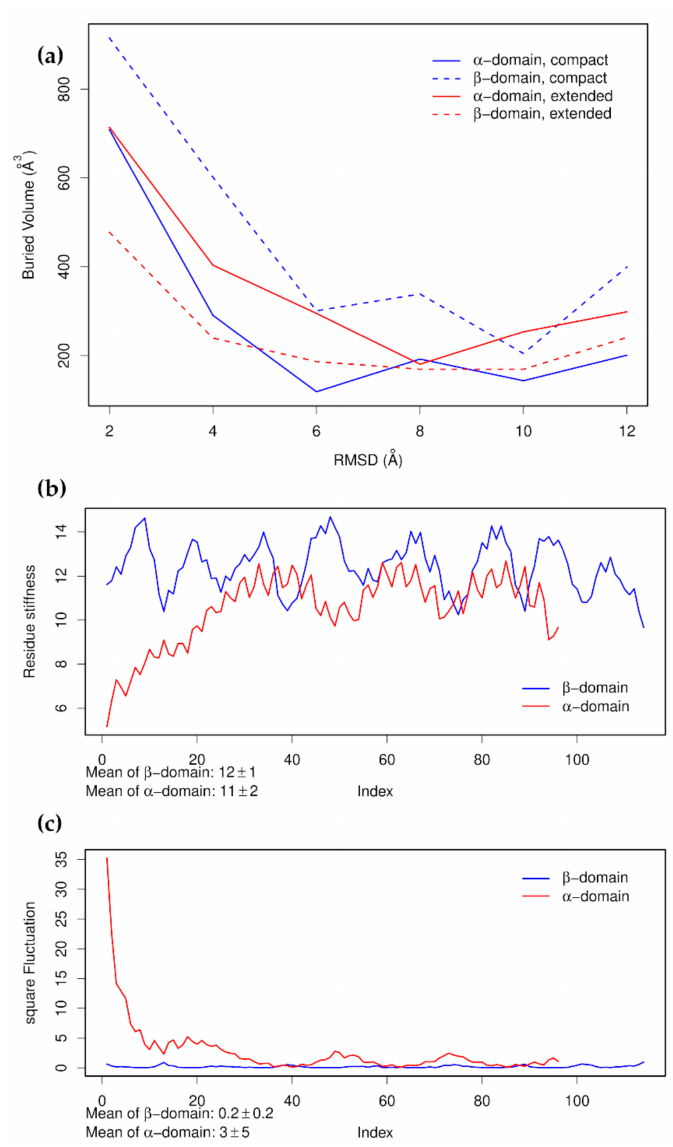
Figure 6. Plots showing ( a ) the buried volumes of the β -domain and α -domain produced by struc- tures distorted with progressively increasing target RMSDs, ( b ) the stiffness of the α -domain and β -domain of the extended form of the SBD calculated separately, and ( c ) the square fluctuations produced by the first 100 non-zero normal modes of these two domains calculated separately. In all panels, the coloring of the domains matches that of Figure 5. It can be seen that although the buried volumes gave different answers for the two different starting structures, when the domains were examined separately, the α -domain was the more flexible